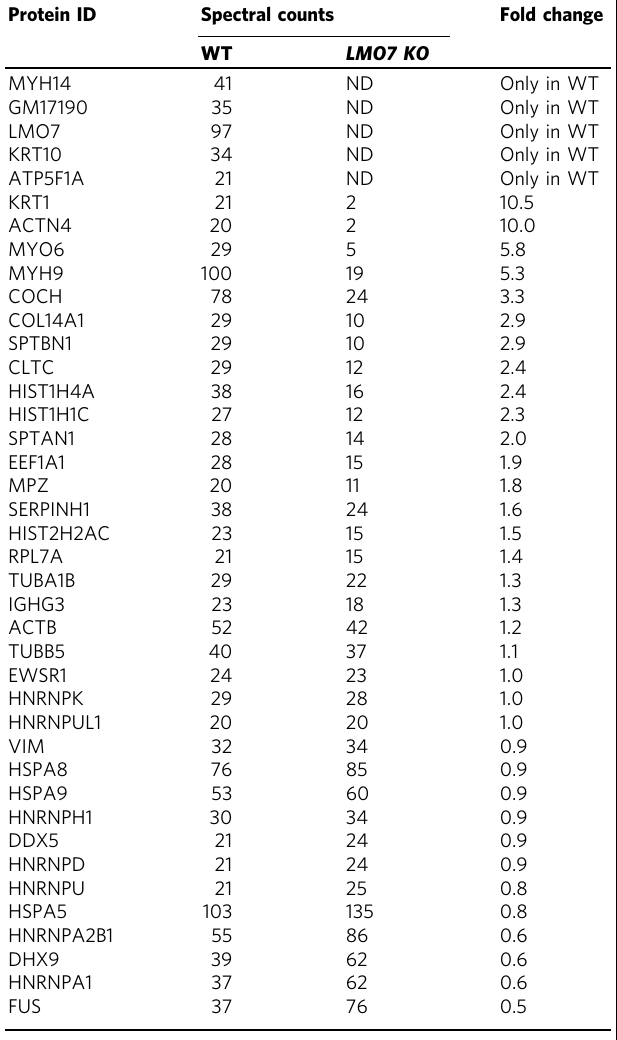
List of 40 most abundant proteins in the WT pulldown, sorted by fold-enrichment in the WT vs. the KO pull-down. Columns indicate protein identi fi ers, spectral counts, and fold change in WT compared to Lmo7 KO